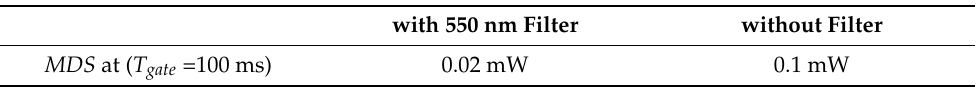
Table 1. Minimum detectable MMW source signal (MDS) measurement results with and without 550 nm long pass filter at T gate =100